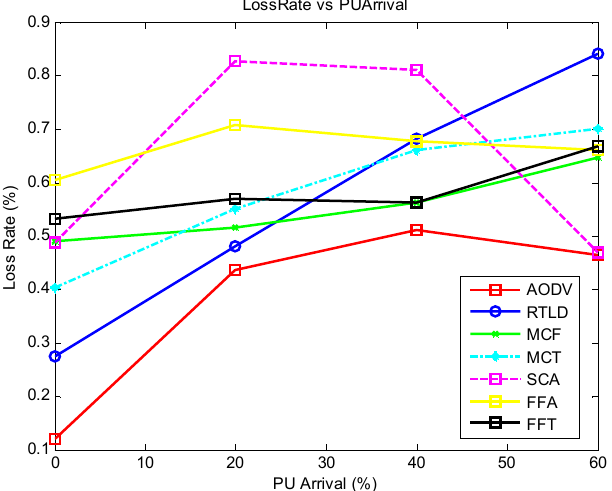
Figure 5. Loss rate of all protocols versus primary user